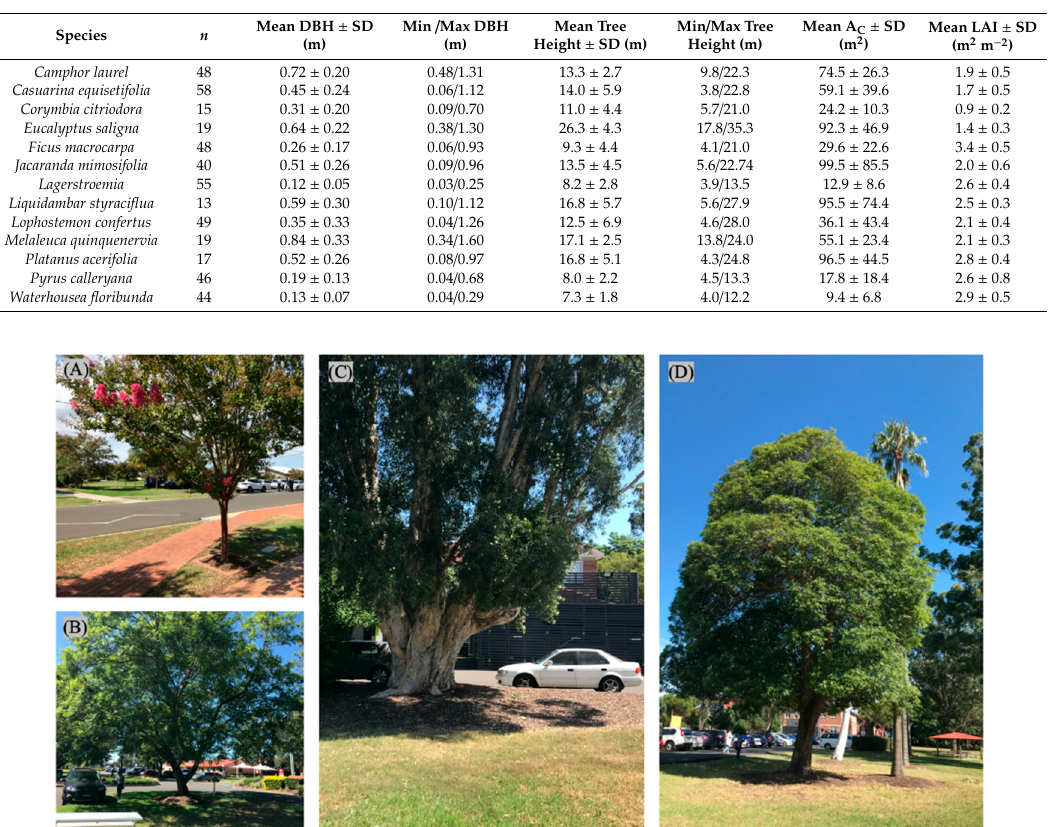
Table 1. Alphabetic list of tree species with their mean diameter at breast height (DBH), total height, vertical crown projected area (A C ) and leaf area index (LAI). N denotes number of trees. Minimum and maximum values for DBH and height, as well as 1 Standard Deviation (SD) are shown.